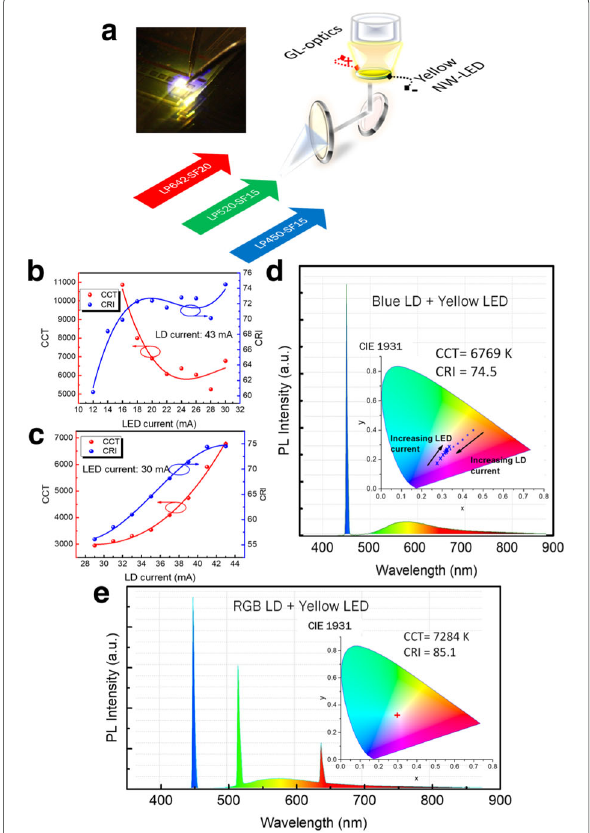
Fig. 7 Color mixing experiment. a Color mixing experiment setup indicating the red, green, and blue LDs and the yellow nanowireon- quartz device. Inset shows optical photograph of LED under laser illumination. b Change in CCT and CRI with varying LED injection current. c Change in CCT and CRI with varying LD injection current. Wavelength spectrum and CIE 1931 map for a color mixing